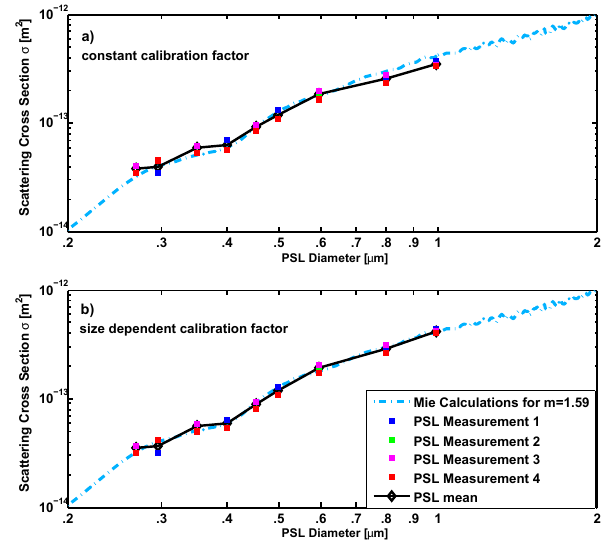
Figure 6. Comparison of measured and theoretical Mie curves cal- culated for m = 1 . 59. The square markers, PSL measurements 1– 4, show results from four different experiments and the black line, PSL mean, shows the mean value over the four experiments. In (a) a constant scattering cross section calibration factor of C σ = 3 . 71 × 10 − 15 m 2 mV − 1 was applied to analyze raw signals of the PSL measurements, while in (b) the voltage-dependent calibration function C σ (V cal ) described in Eq. (9) and Fig. 7 was